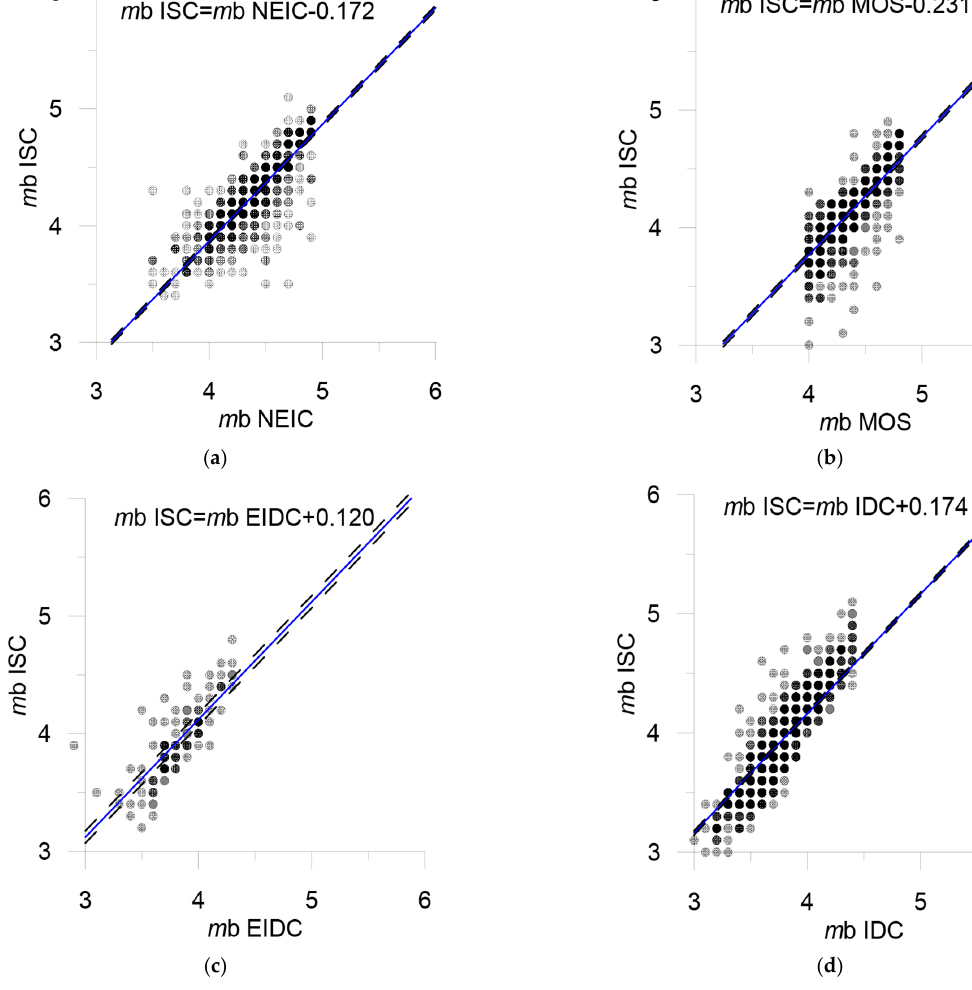
Figure 15. ( a ) NEIC; ( b ) MOS; ( c ) EIDC; and ( d ) IDC. Correlations of the “shift” type are determined in the interval of the magnitudes indicated in Table 4. The dashed lines show 95% confidence intervals.